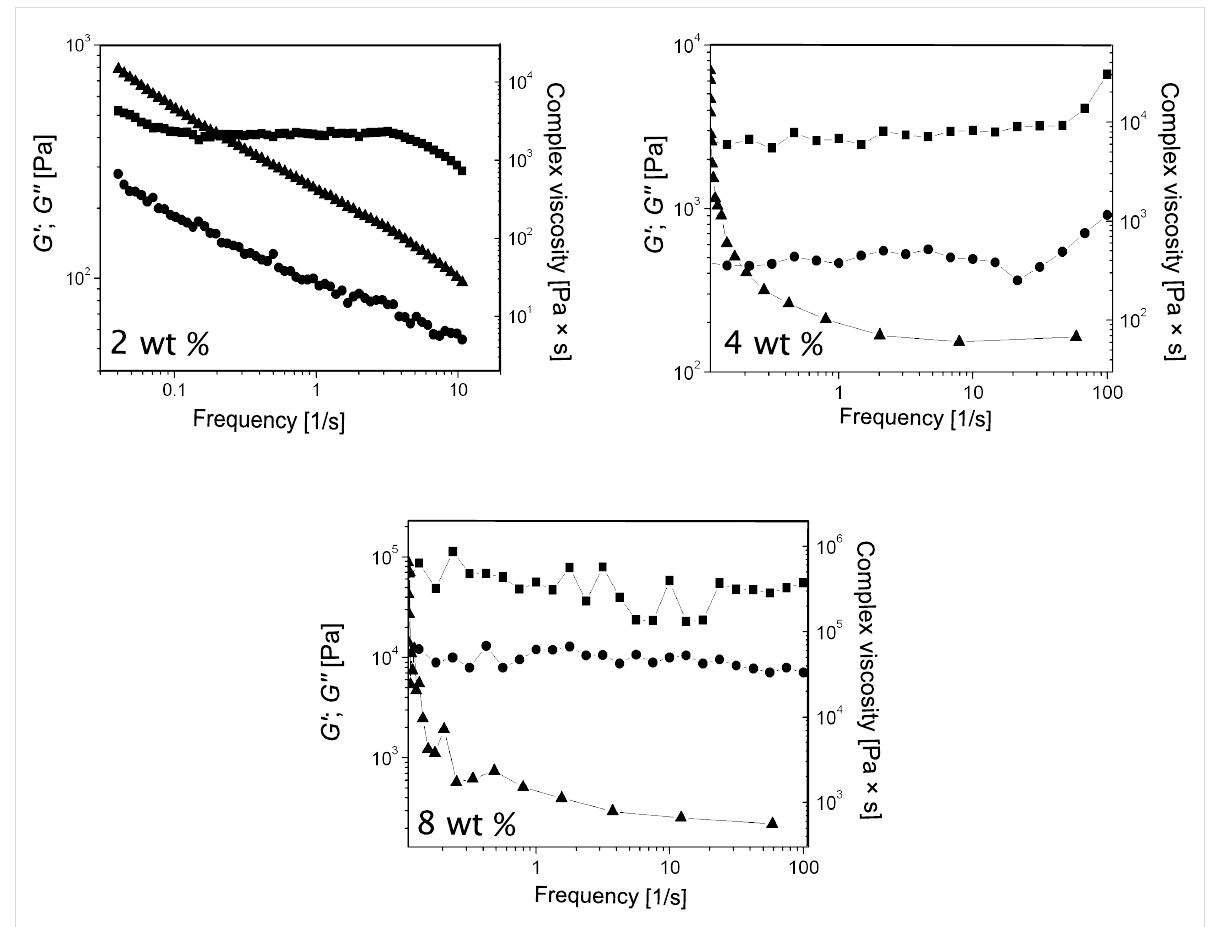
Figure 6: Frequency sweep tests and dynamic mechanical measurements of 2, 4, and 8 wt % ODA-C /silicone oil gels. G ′ ( ■ ), G ″ ( ● ), and the com- plex viscosity , η * ( ▲ ; right axes) as a function of frequency, ω .